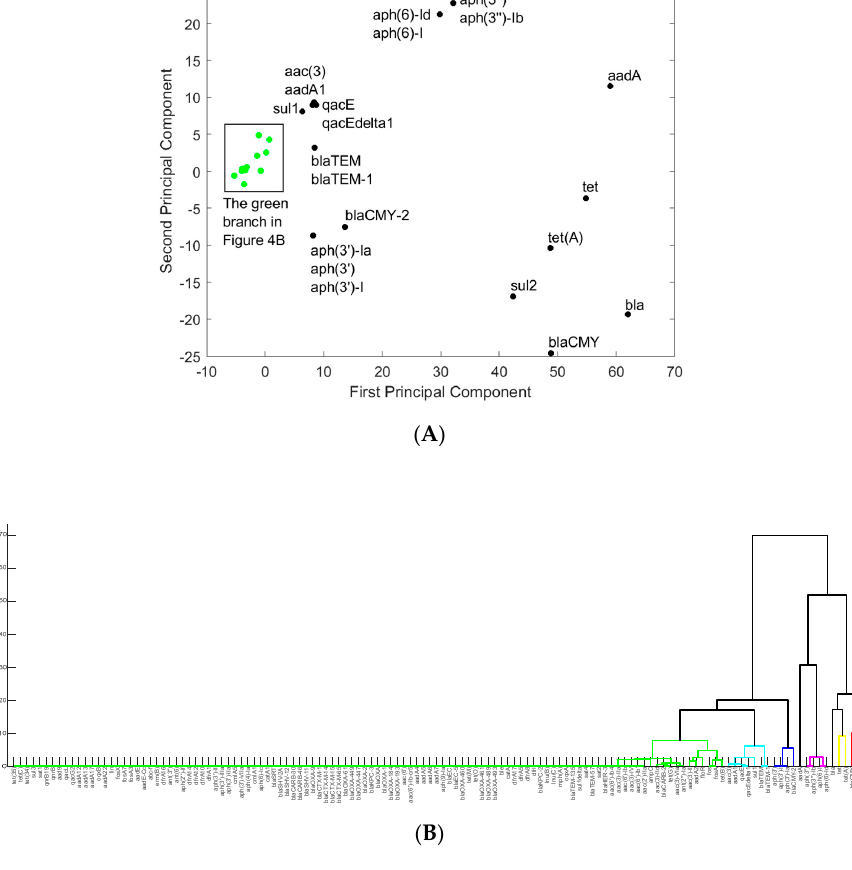
Figure 4. The representation of antimicrobial-resistance genes in the space of principal components one and two ( A ) and in the hierarchical clusters ( B ) for Pennsylvania. The genes shown in Green in ( A ) are listed in the Green branch in ( B ). Table 2. The most common antimicrobial-resistance genes shared by the six states.